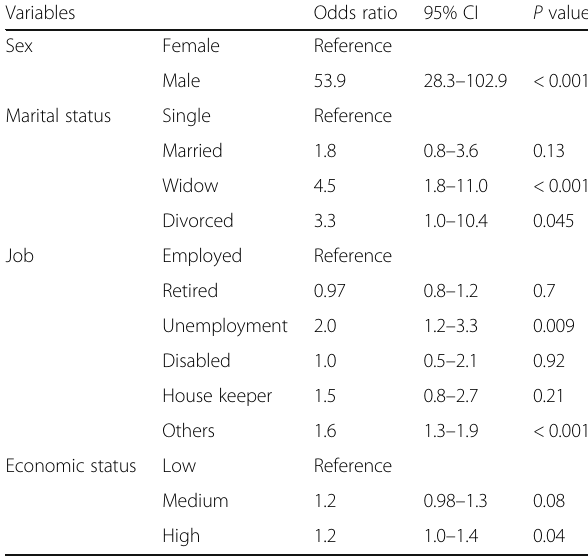
Table 2 Multiple population-averaged logistic regression for predictors of tobacco smoking among middle-aged population of Shahroud, Iran; 2009 –